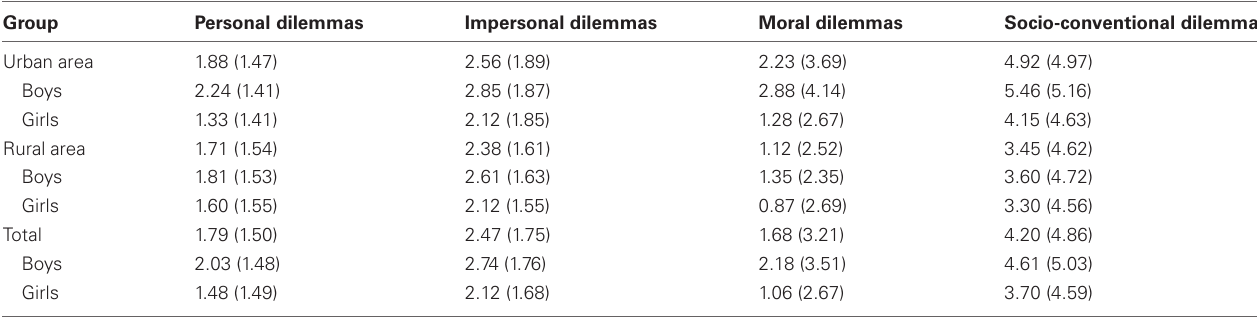
Table 2 | Mean scores (and standard deviations) of personal vs. impersonal and moral vs. socio-conventional dilemmas in ANOVA including area as fixed factor.